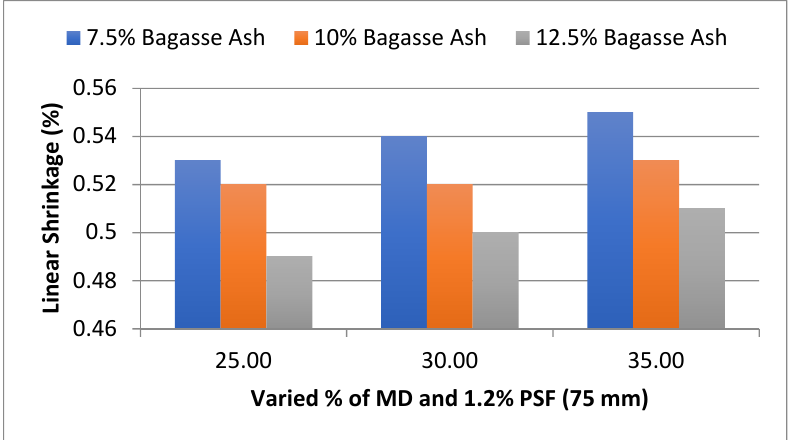
Figure 13. Effect of MD and BA on linear shrinkage of block reinforced with 1.2% PS fiber (75 mm).